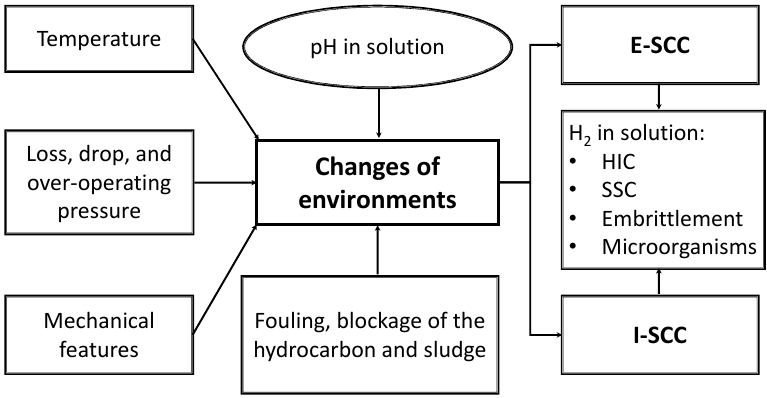
Figure 1. Main factors required to develop stress corrosion cracking (SCC).